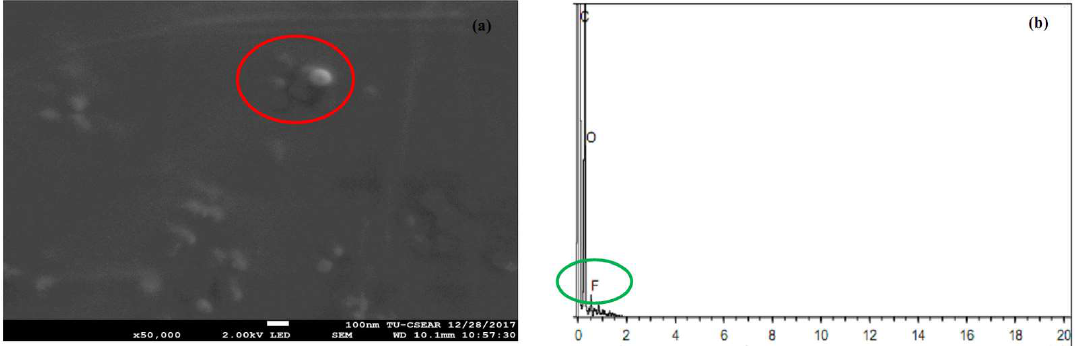
Figure 4. The field emission scanning electron microscope image ( a ) and energy-dispersive x-ray spectroscopy spectrum ( b ) of the TA-loaded